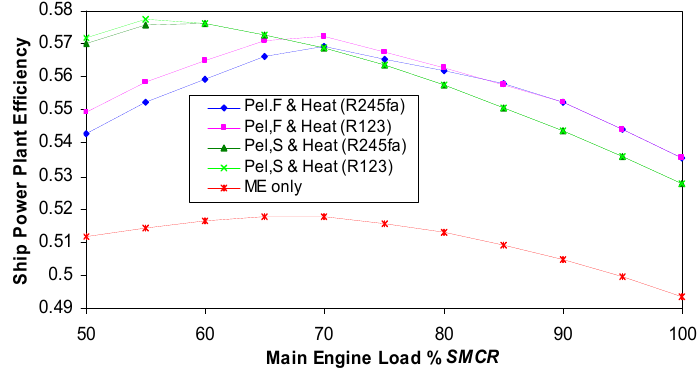
Figure 18. Ship Power Plant Efficiency with organic fluids— η CHP,ship total (power and